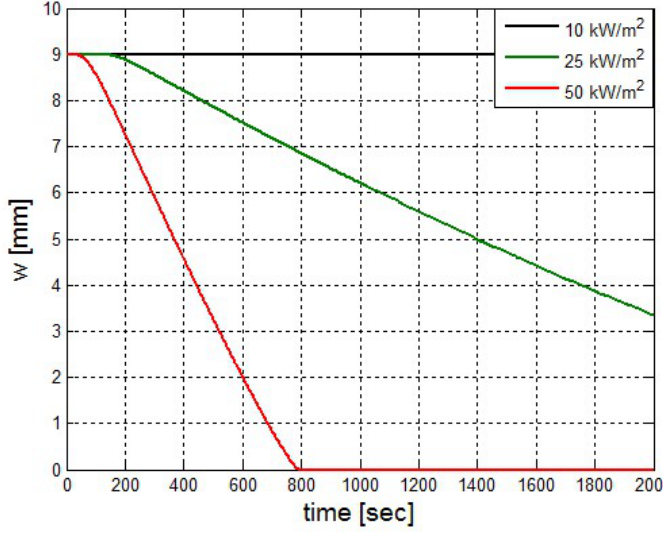
Figure 10 . Predicted thickness of the composite as a function of time for different heat fluxes.